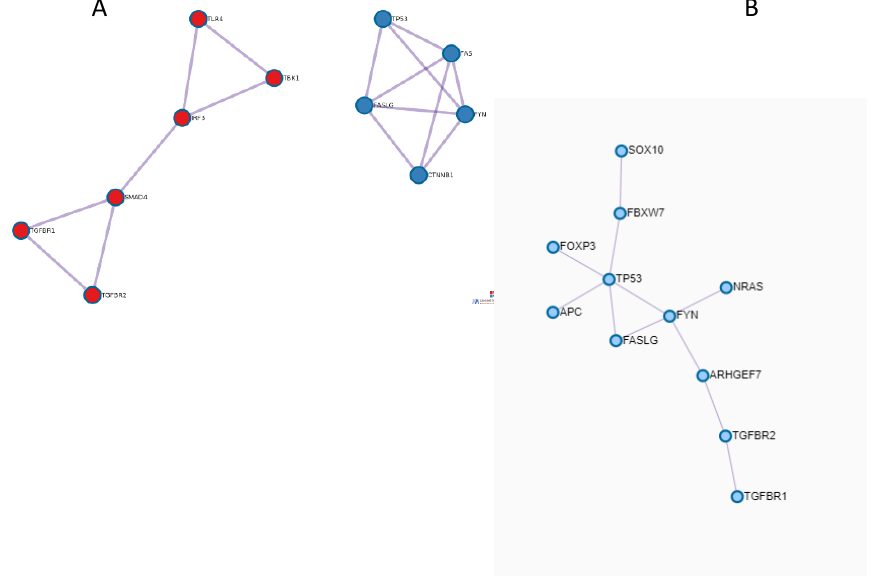
Figure 3. Interaction networks of the alterations detected in ( A ) long survival samples and ( B ) in short survival samples. In Table 1, significantly enriched terms are shown according to the sub-network color scale. PPI network was built up also for the short responder case (Figure 3B) and functionally enriched (Table 1).